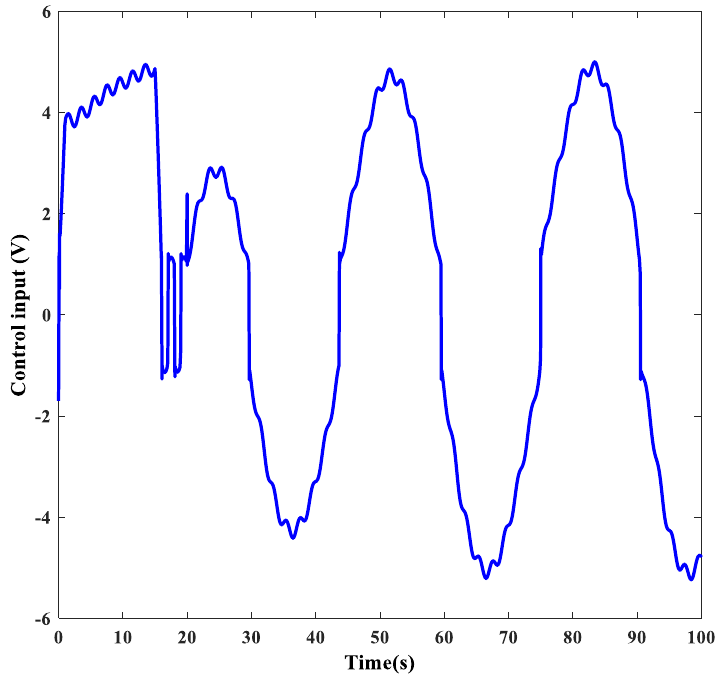
Figure 14. The control input of the ADRAC.